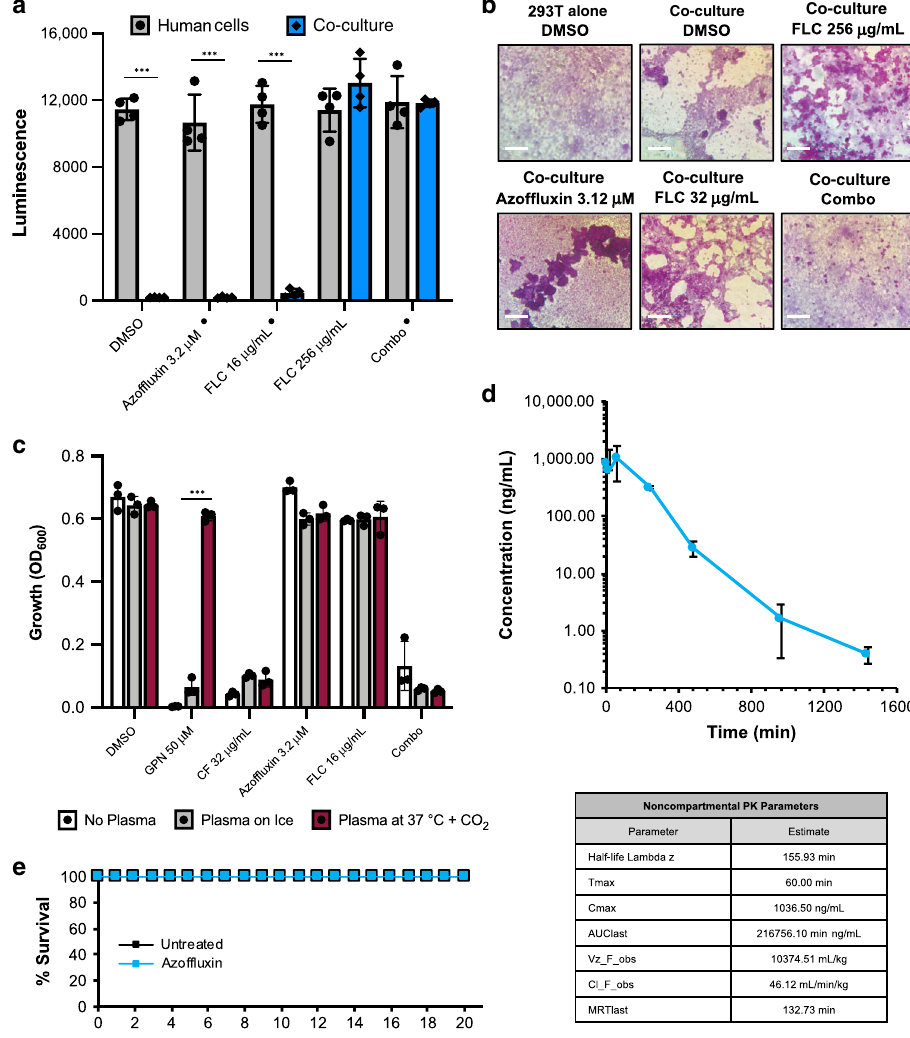
Fig. 7 Preliminary characterization of the in vivo potential of azof fl uxin. a Human cells (293T) expressing luciferase were grown in DMEM medium overnight. 24 h later the indicated concentrations of compounds ( (cid:129) indicates concentrations of fl uconazole (FLC) and azof fl uxin used in combination (combo) treatment) were added to cells alone (gray) or those infection with C. auris (blue). Co-cultures were incubated for 48 h at 37 °C followed by measurement of luminescence. Data are presented as mean ± SD of quadruplicate wells. Signi fi cance of differences between 293T cells alone versus co- cultures was determined by two-sided unpaired Student ’ s t test, (*** p -value < 0.001 b Periodic-Acid Schiff (PAS) staining was used to visualize cells in co- culture. Light purple staining identi fi es 293 T cells and the bright pink signal indicates C. auris . Scale bar represents 50 µ m. c Plasma stability of azof fl uxin and relevant control compounds, gepinacin (GPN) and caspofungin (CF). Samples were incubated in 100% mouse plasma at either at 37 °C with 5.5% CO 2 (maroon) or on ice (gray), or in the absence of serum in YPD (black). The drug-plasma mixtures were diluted 1:10 into C. auris Ci6684-inoculated YPD medium. Relative growth was measured after 48 h at 30 °C by OD 600 . Data are presented as mean ± SD between technical triplicates, two-sided unpaired Student ’ s t test was used to determine signi fi cance of difference between 37 °C with 5.5% CO 2 condition compared to ice condition for each